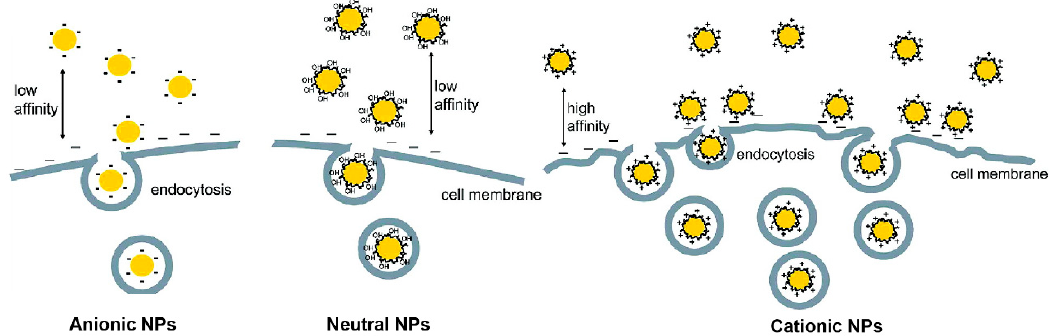
Figure 4. Schematic illustration of the interactions between NPs with different types of surface charges and cells. (Adapted with permission from Reference [77]; Published by American Chemical Society, 2009).